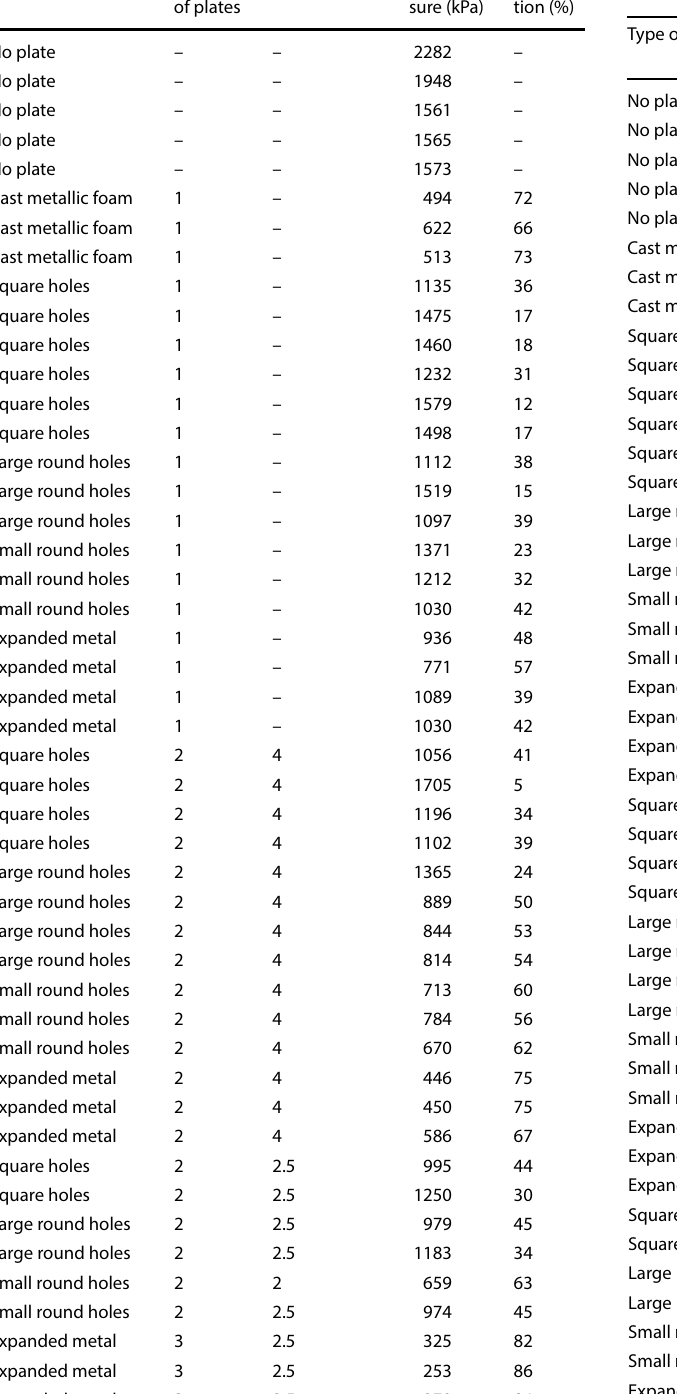
Table 2 Initial reflected overpressure measured by the sensor inserted in the wall located 50 mm downstream from the porous barriers for all experiments Table 3 Maximum impulse obtained with the sensor inserted in the wall located 50 mm downstream from the porous barriers